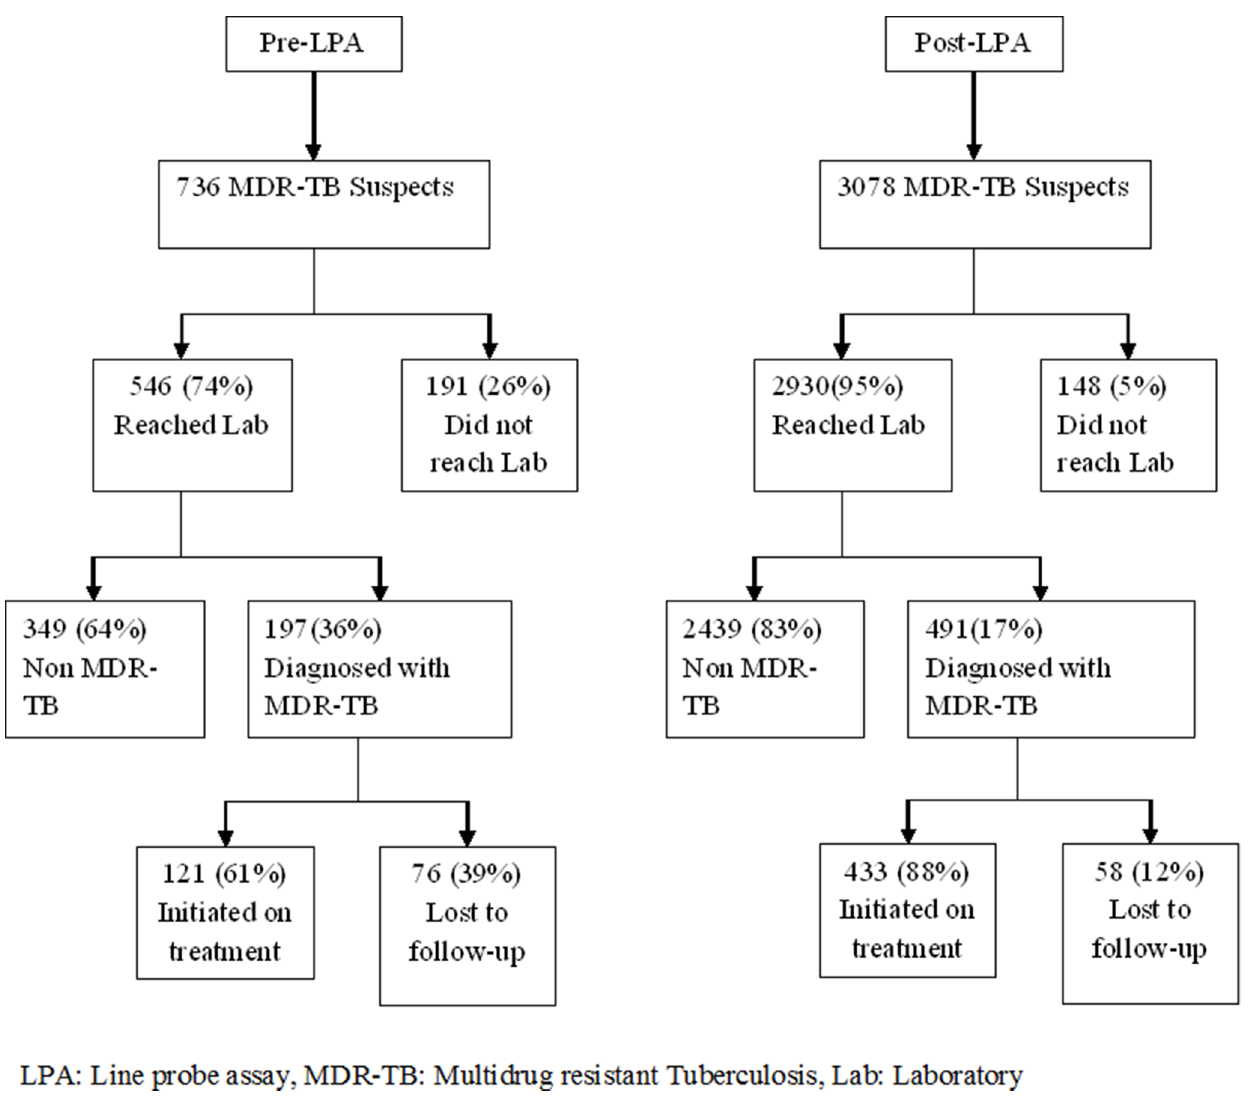
Figure 1. Pre-treatment loss to follow-up rate among MDR-TB suspects before and after diagnosis is in the pre-LPA and post-LPA periods at New Delhi, India. doi:10.1371/journal.pone.0102989.g001 PLOS ONE |